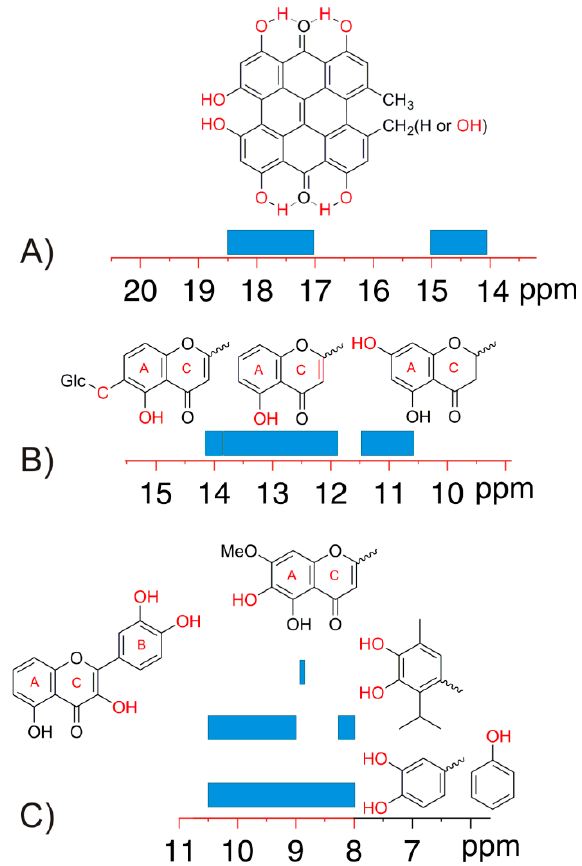
Figure 8. Classification of the chemical shifts of the –OH groups in DMSO- d of the structure of the molecule and the nature of the substituent in the rings. ( A ), ( B ) and ( C ) are the 15–20 ppm, 10–15 ppm, and 8–10 ppm regions,